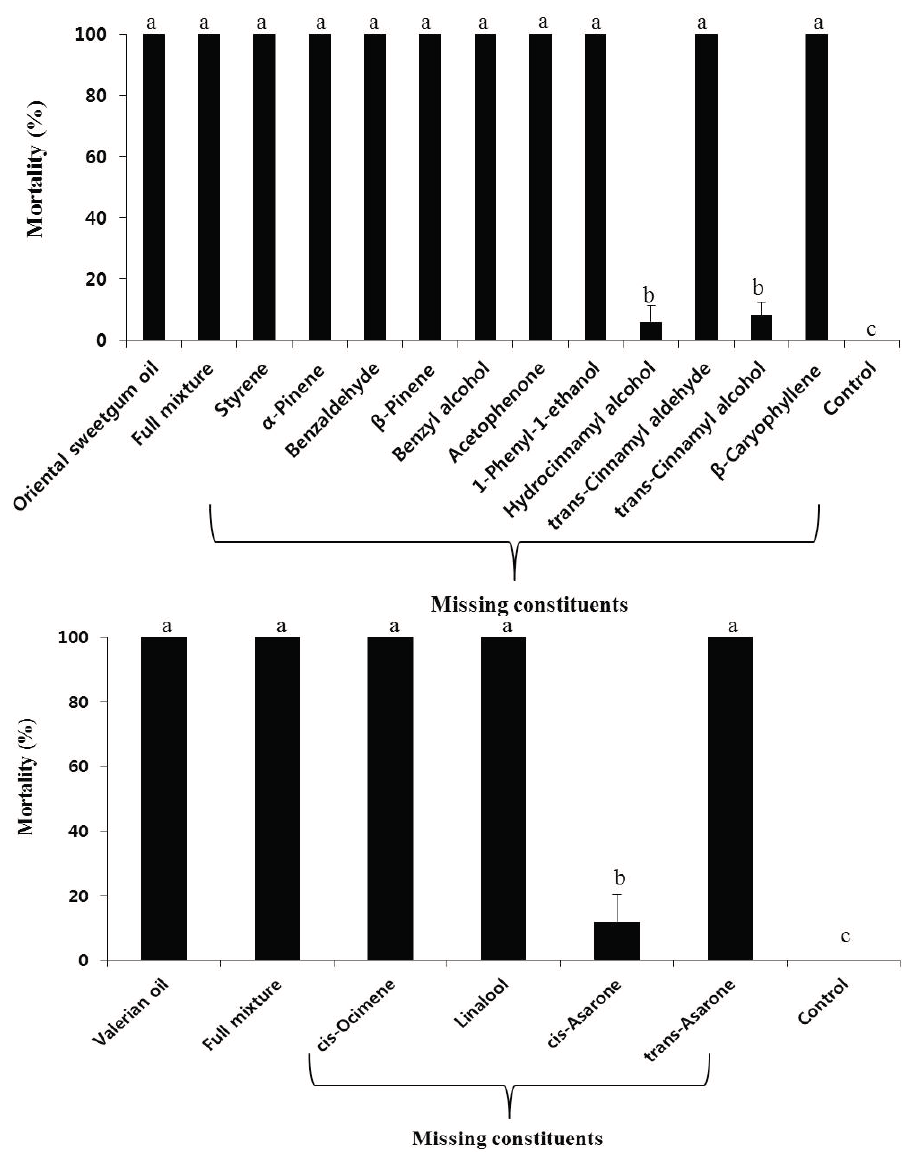
Figure 1. Fumigant toxicities of oriental sweetgum, valerian oil, a full mixture, and selected blends of the constituents in Japanese termite adults 7 days after treatment. The concentrations of oriental sweetgum and valerian oil were 2.5 and 10 mg/L air, respectively. The concentrations of the full mixture of oriental sweetgum and valerian oil were 2.37 and 9.24 mg/L air, respectively. The concentrations of the other blends were determined by removing each constituent equivalent to the ratio identified in oriental sweetgum oil. Mean values corresponding to each treatment with different letters are significantly different from each other (oriental sweetgum oil: F = 250.66, p < 0.0001; 13, 56 valerian oil: F = 1057.90, p < 0.0001, Scheffé’s 6, 28